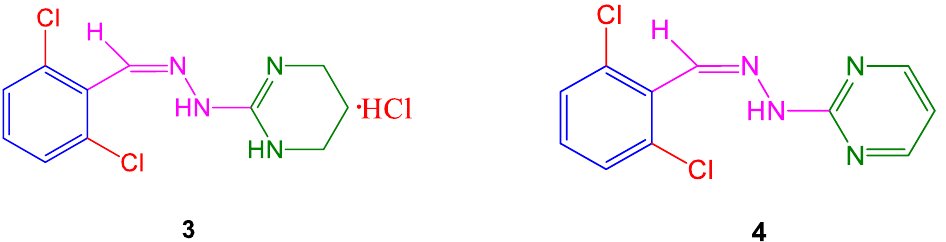
Figure 3. Compounds ( 3 and 4 ) with anti-hypertensive and antibacterial activities.